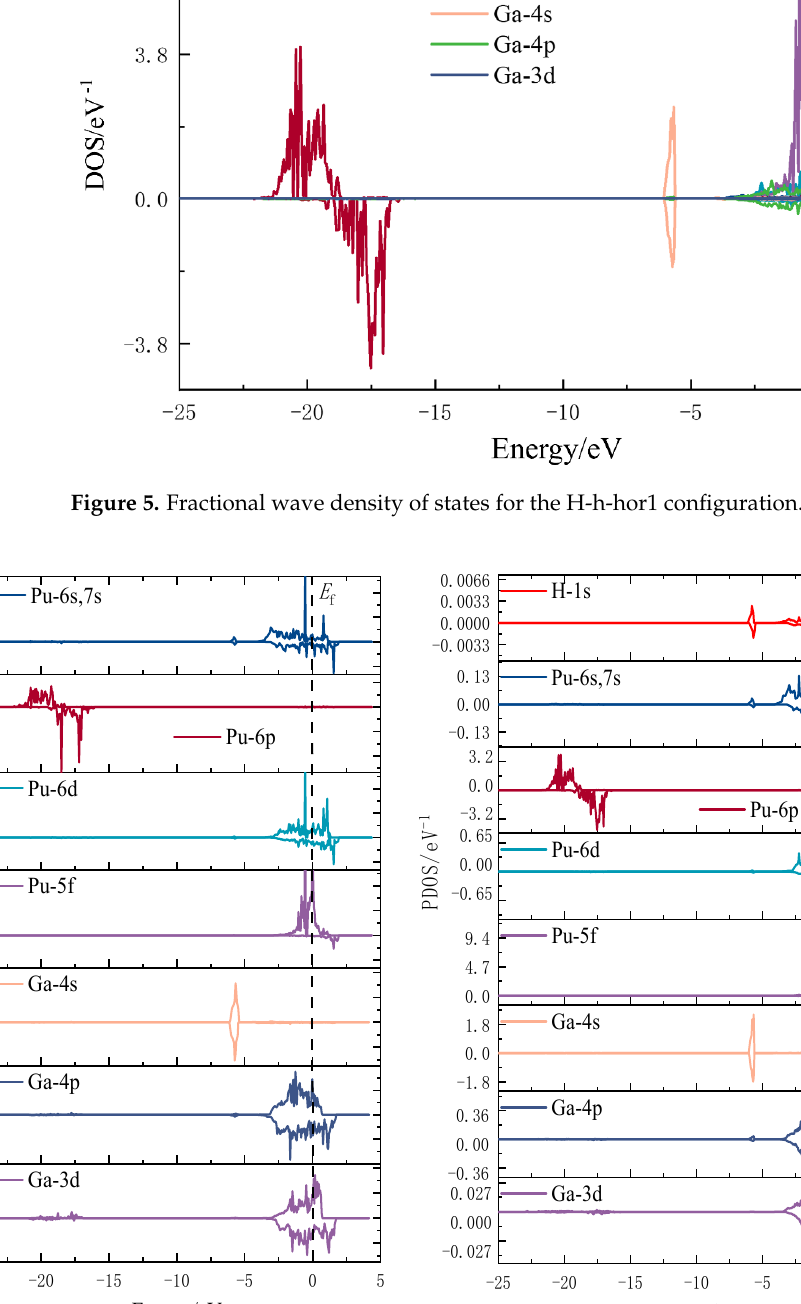
after adsorption, and no new density of states peaks are generated.